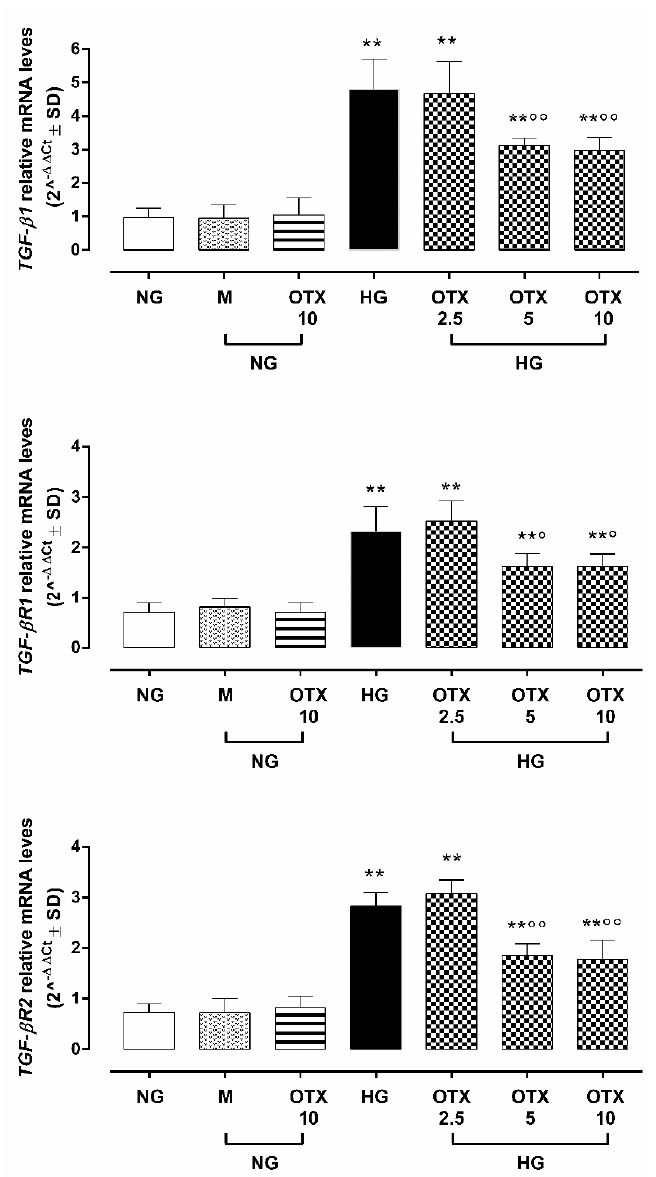
Figure 4. TGF- β signaling in ARPE-19 cells. Cell TGF β 1 , TGF β R1 , and TGF β R2 relative mRNA levels, reported as 2 ˆ − ∆∆ Ct ± SD and quantized by using GAPDH as control. N = 9 observations per group (three independent experiments, each performed in triplicate). ** p < 0.01 vs. NG; ° p < 0.05 and °° p